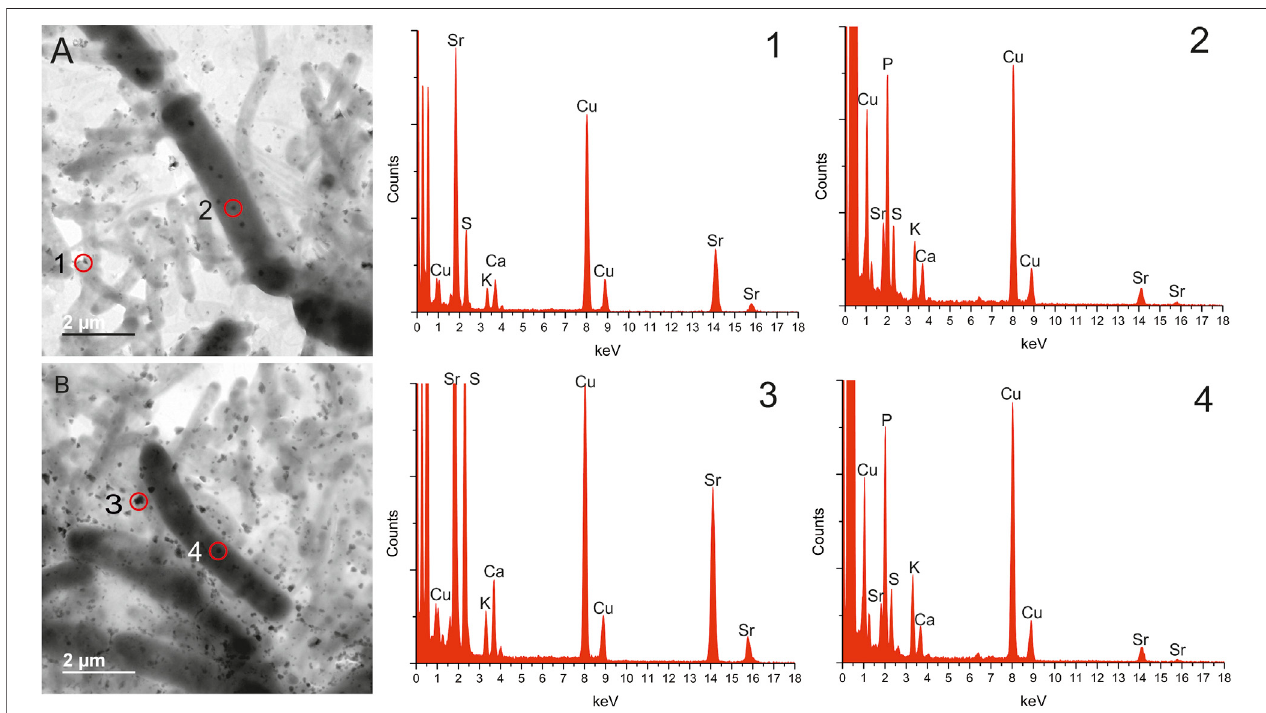
FIGURE 2 | Transmission electron microscopy images and energy-dispersive X-ray spectroscopy data taken from samples of P. catenata cultures incubated with SrCl 2 at day 20, washed twice. Energy-dispersive X-ray spectroscopy data corresponds to the numbers on transmission electron microscopy images, site of scans indicated by red circle. All scale bars represent 2 μ m.